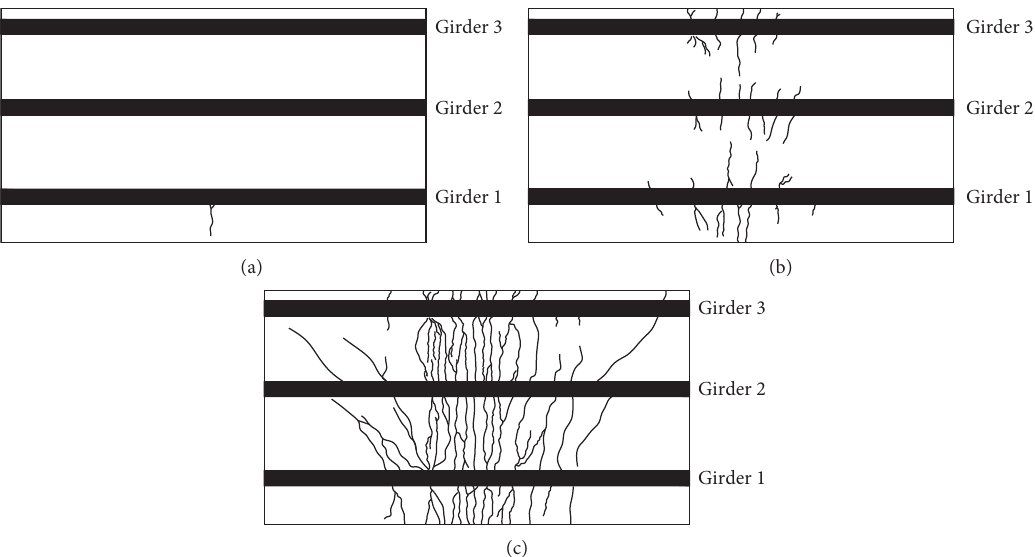
Figure 7: Crack patterns in different hydraulic loading cases: (a) Case 3; (b) Case 4; (c) Case 5.